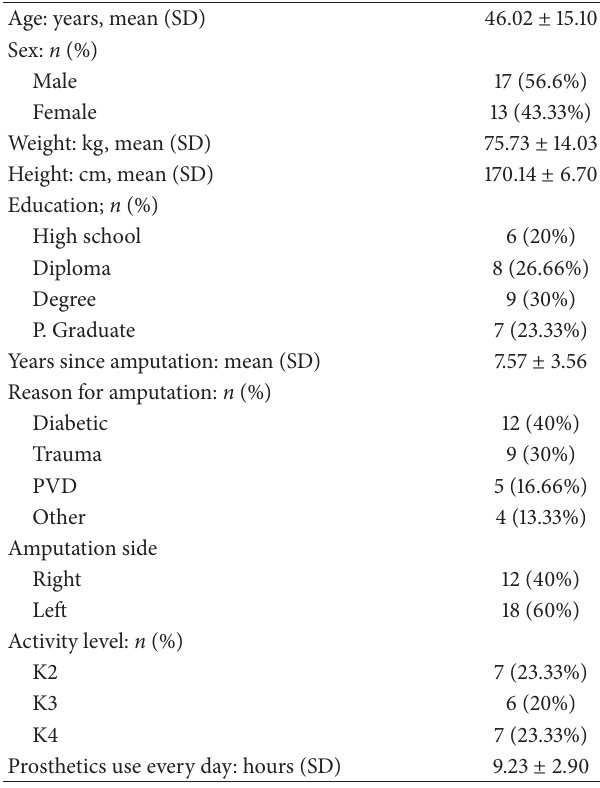
Table 1. University Malaya Medical Centre ethics